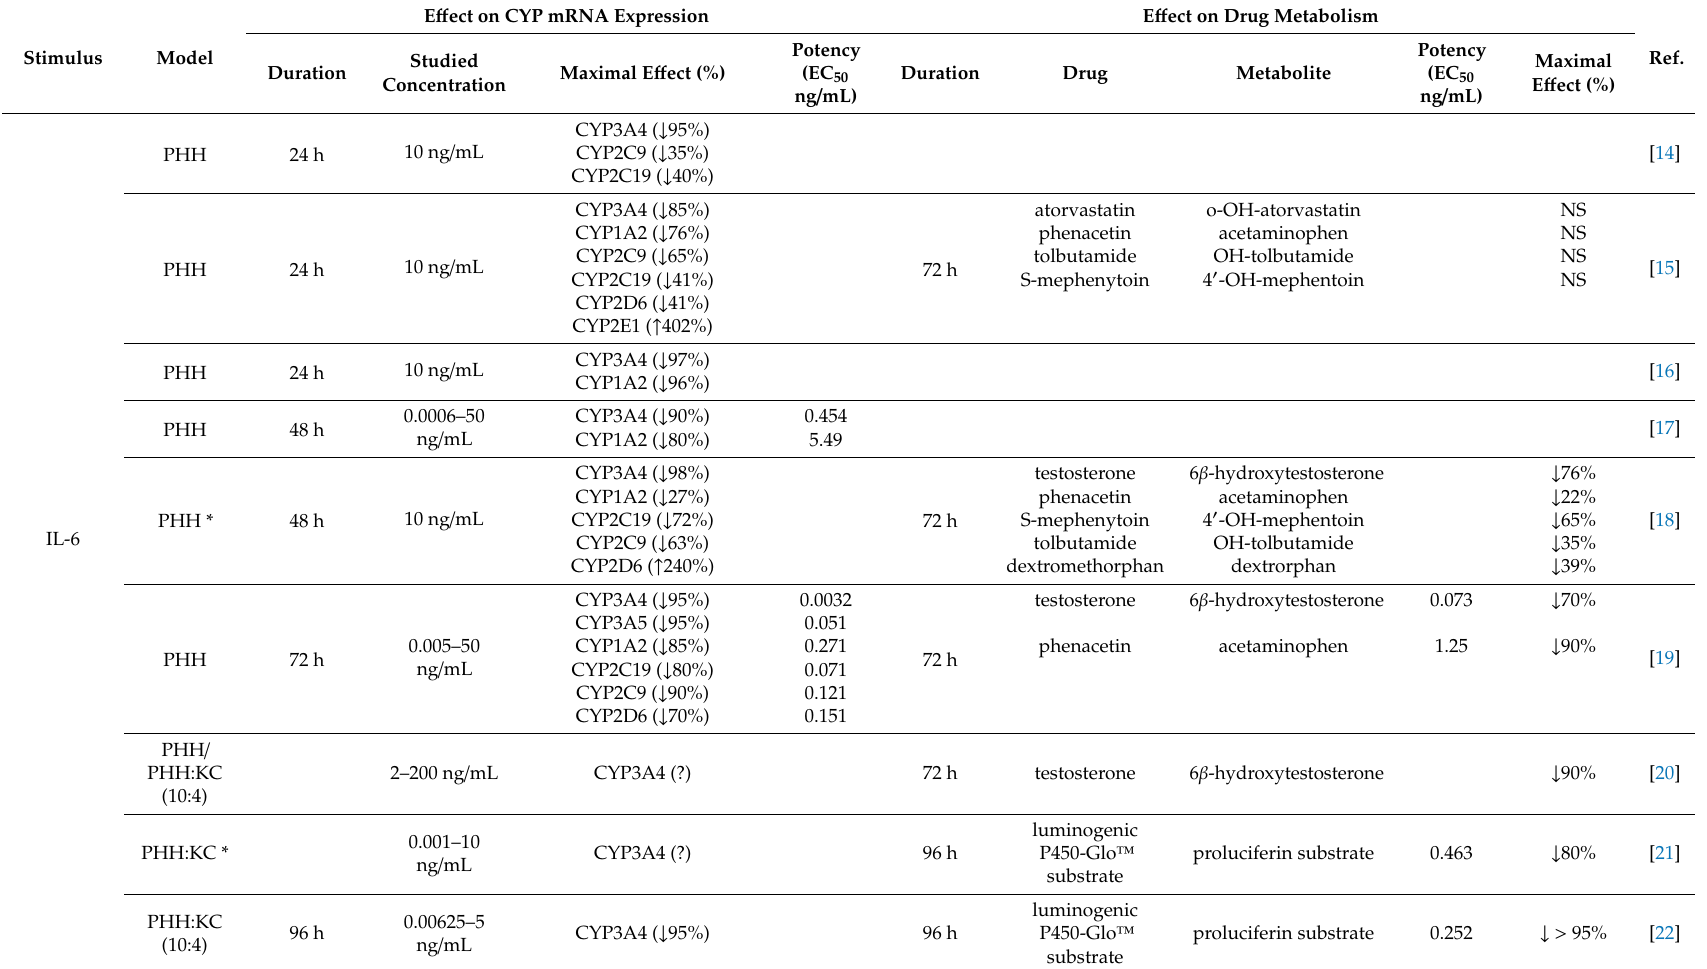
Table 1. Regulation of Clinically Important Drug-Metabolizing Cytochrome P450 Enzymes by Pro-Inflammatory Stimuli in Relevant Human in-Vitro Models.